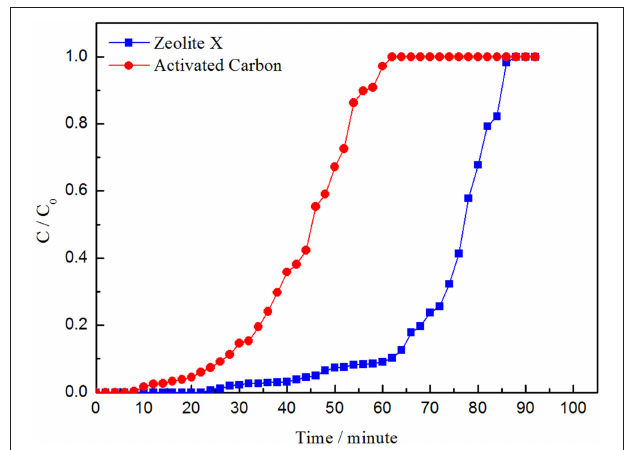
FIGURE 10 | Adsorption curves of isopropanol by zeolite X and activated carbon.